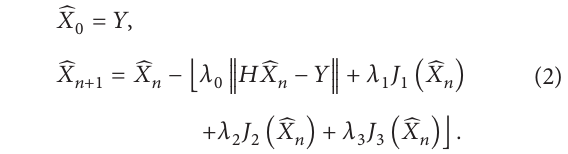
Figure 3: The stress dependences on (a) 𝑆 beam spot